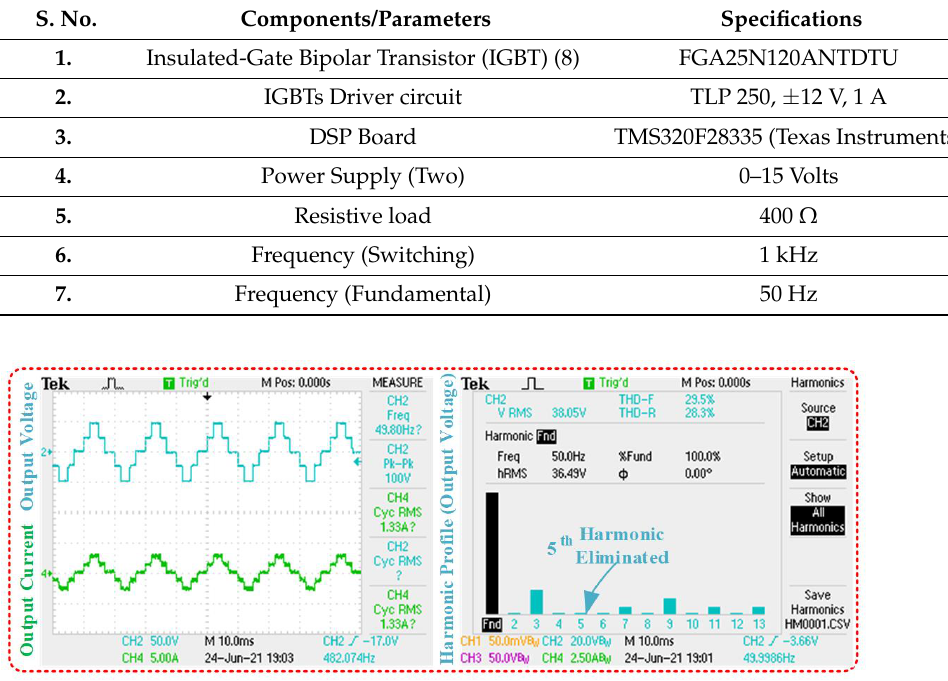
Figure 25. Outputs and harmonic profile of seven-levels MLI. Figure 26. Outputs and harmonic profile of nine-levels MLI. 8. Conclusions In this paper, the CryStAl has been used for eliminating the undesired harmonics from the output of a CHB-MLI. This helps in evaluating the optimum switching angle by solving the non-linear transcendental equation which helps in eliminating the lower-order harmonics and therefore improving the THD of the output voltage. This gives the opti- mized value of α for different output voltage. This gives α 1 and α 2 equals 29.04° & 64.96° for five-level output. α 1 , α 2 and α 3 equals 20.40°, 51.72° & 64.67° for seven levels output and α 1 , α 2 , α 3 and α 4 equals 30.29°, 43.75°, 57.83° & 67.90° for nine levels output. The re- moval of low-order harmonics in 5 levels, 7 level, and 9 level inverters using CryStAl